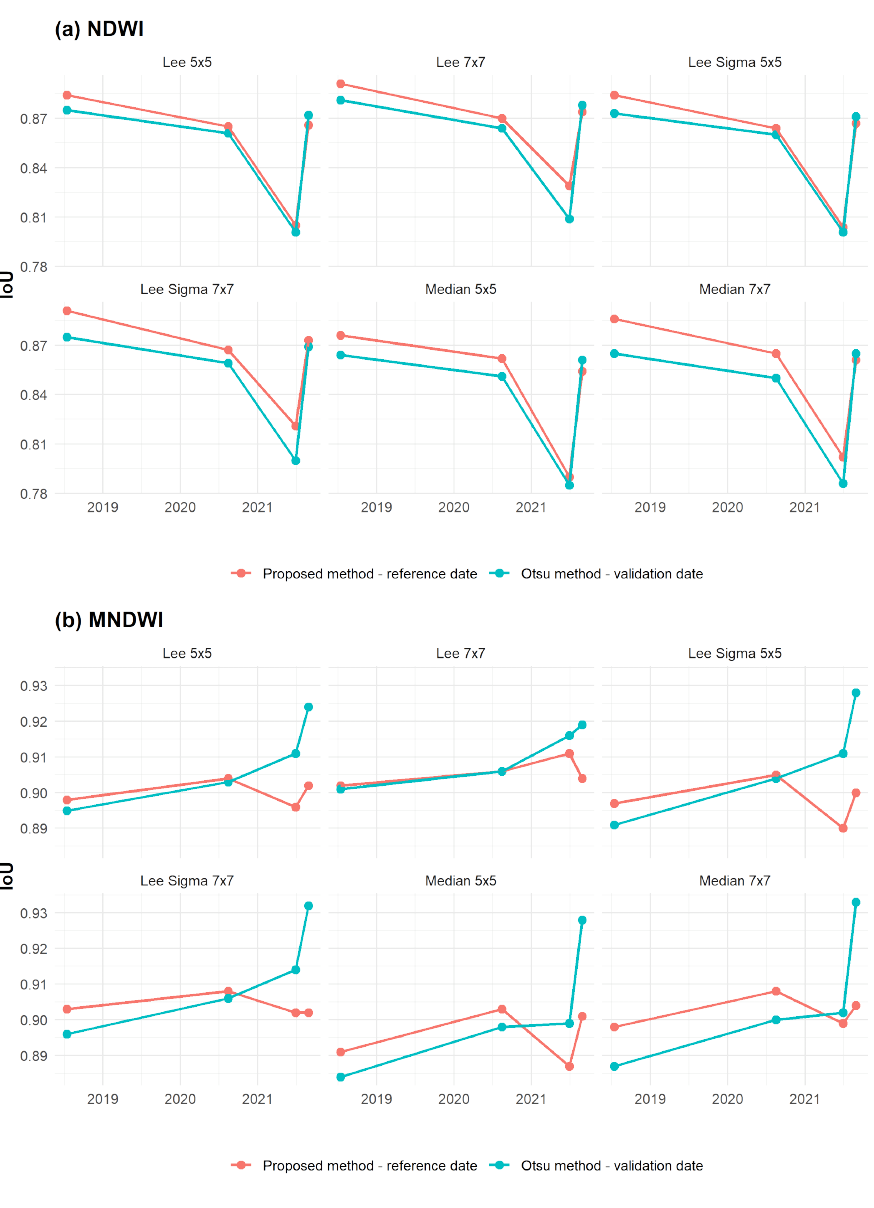
Figure 14. Comparison of the accuracy of optimal thresholds determined on reference dates and applied on validation dates with thresholds determined on validation dates using the Otsu method: ( a ) NDWI and ( b ) MNDWI